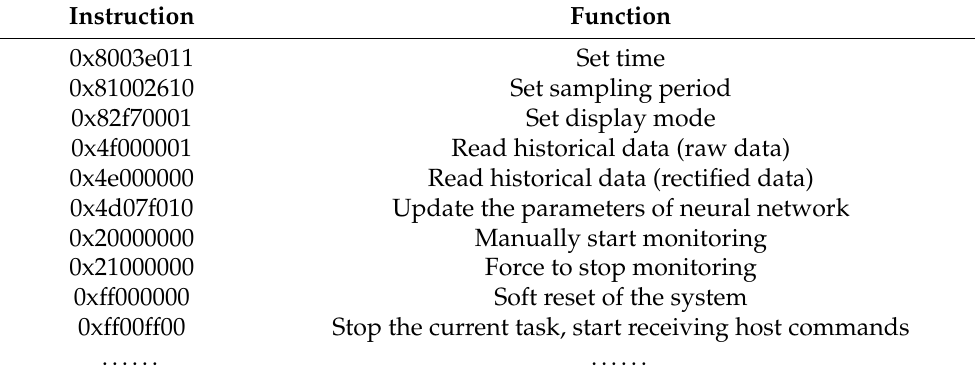
Table 2. Part of the instruction set.